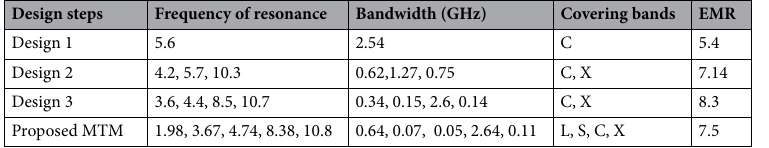
Table 2. Performance comparison for different design-evolution steps toward the proposed unit cell.